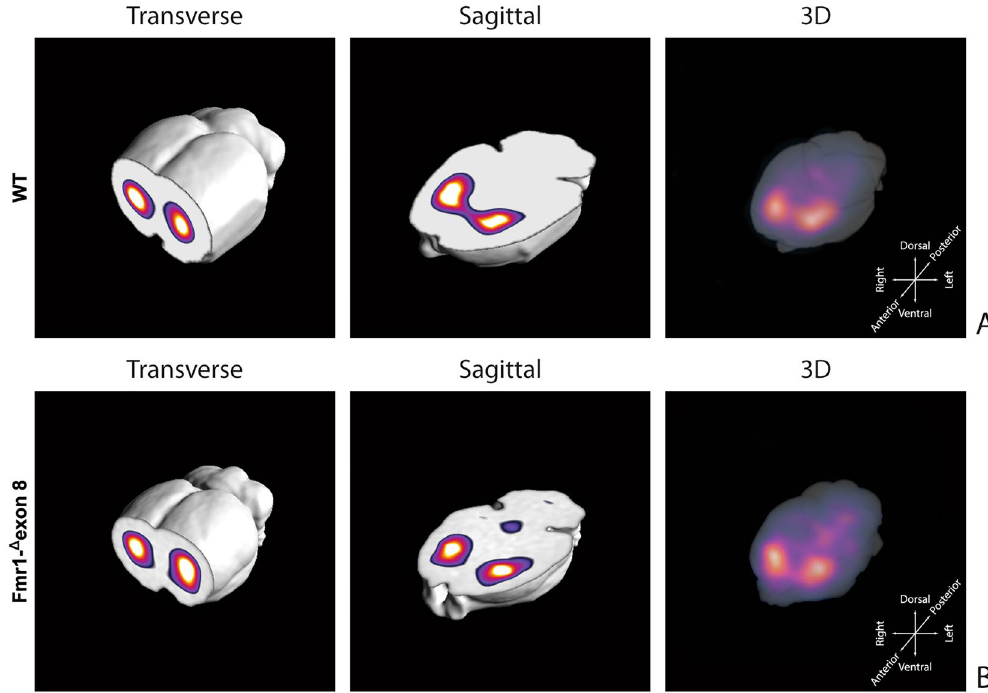
Figure 5. Rat brain volumetric rendering applying the 2-step trans-axial SSR technique. ( A ) [ 123 I]FP-CIT 3D uptake in WT adult rats. ( B ) [ 123 I]FP-CIT 3D uptake in Fmr1- Δ exon 8 adult